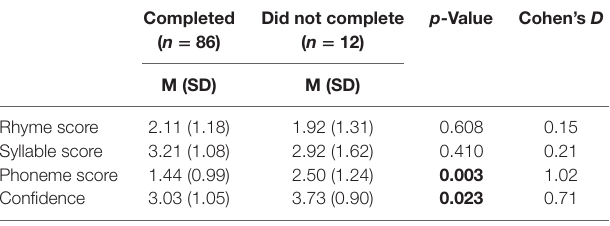
TaBle 1 | Baseline phonological awareness scores of parents who did and did not complete the